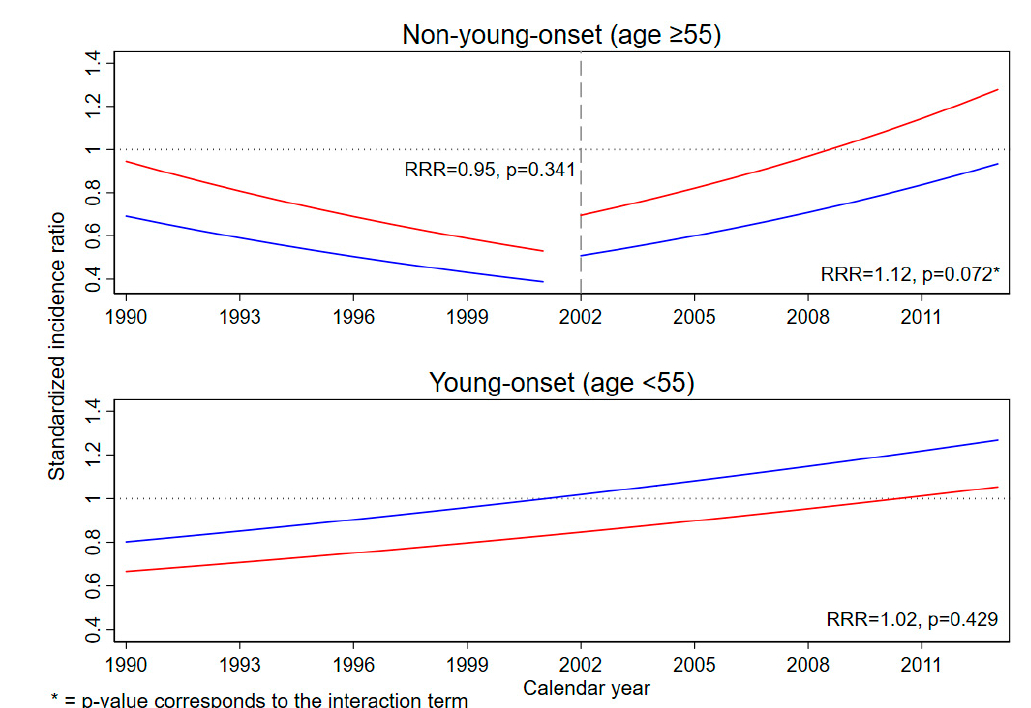
Figure 2. Modeled standardized incidence ratios for colorectal cancer among resettlers compared to the direct host populations using Poisson regression from 1990 to 2013; the relative SIR change (RRR) corresponds to the modeled calendar year effect (see Appendix A); the dashed line indicates the year of screening colonoscopy introduction; the blue line represents men, red line women.